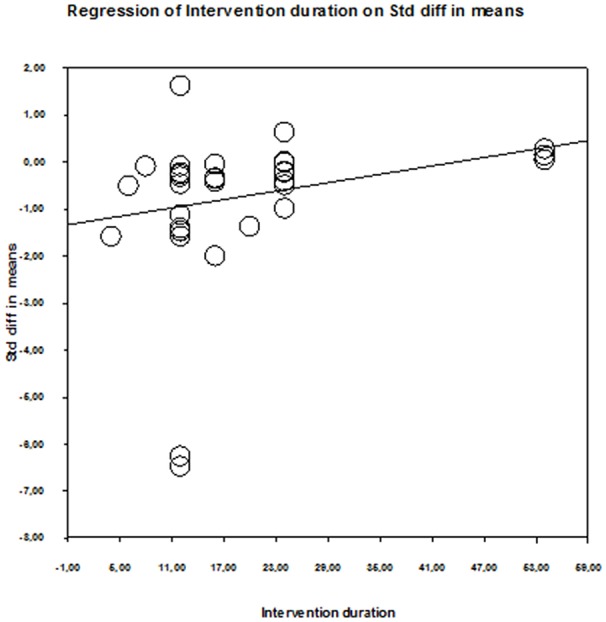
Scatter plot of regression analysis showing influence of intervention duration on the quality of life of older patients with HF.